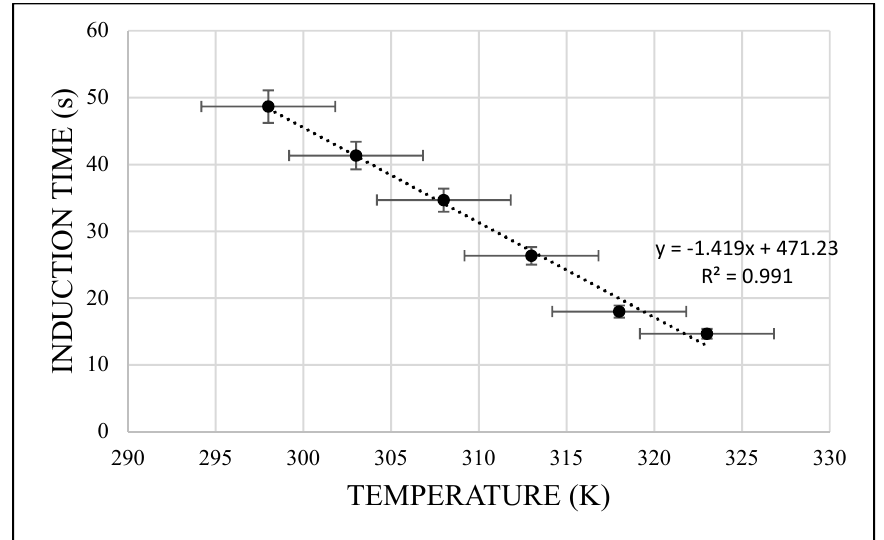
Figure 5. Induction time as a function of temperature.